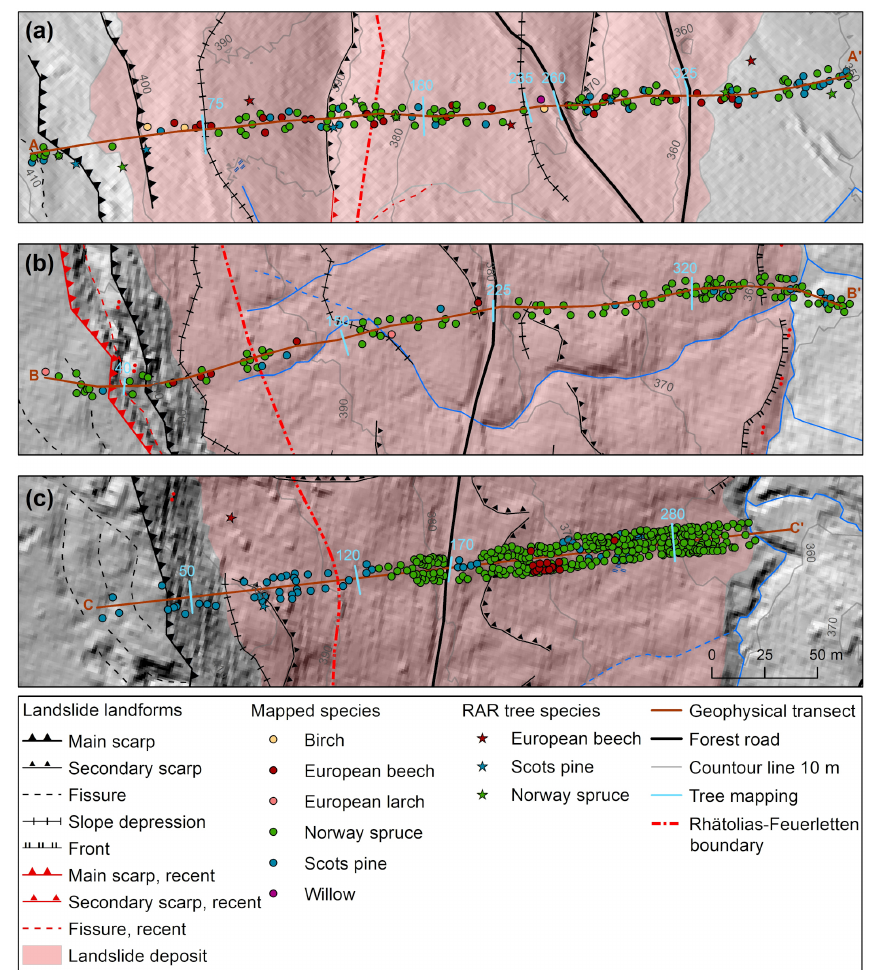
Figure 6. Mapped trees with height above 4m with up to 5m of distance to the ERT transects (Fig. 5) at (a) Putzenstein, (b) Weinreichsgrab and (c) Fürstenanger. The locations of ERT transects are shown in Fig. 3.